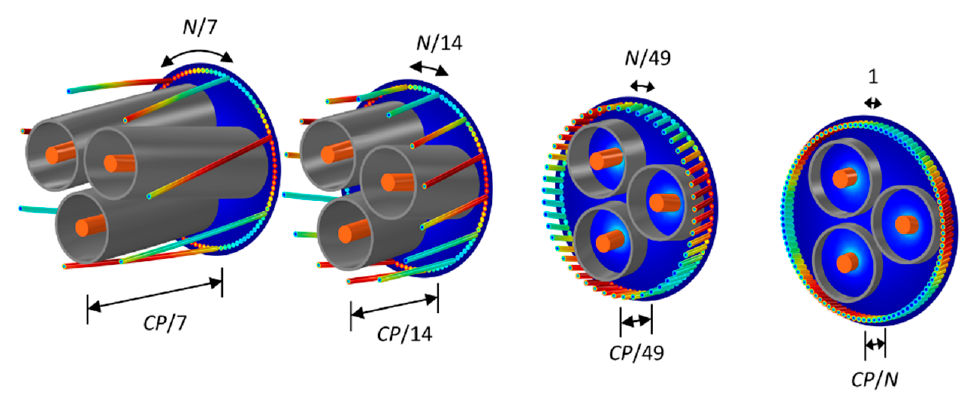
Figure 3. Armor wires required for reproducing the full pattern of one single armor wire for all n values and the length of the resulting geometry.